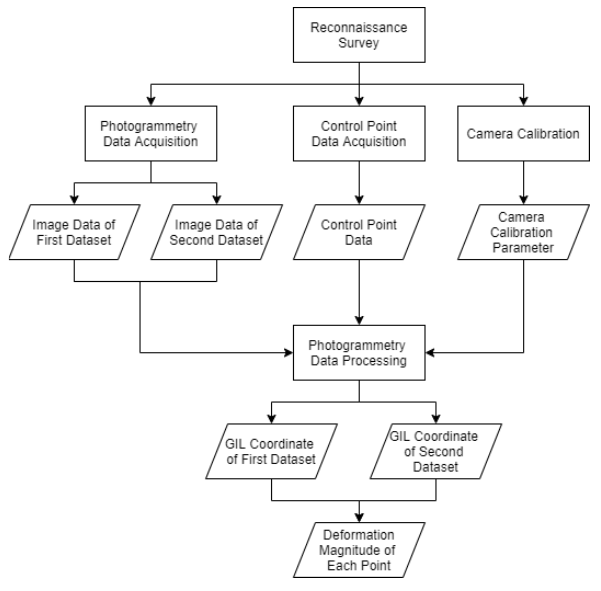
Figure 1. Schema of the proposed method